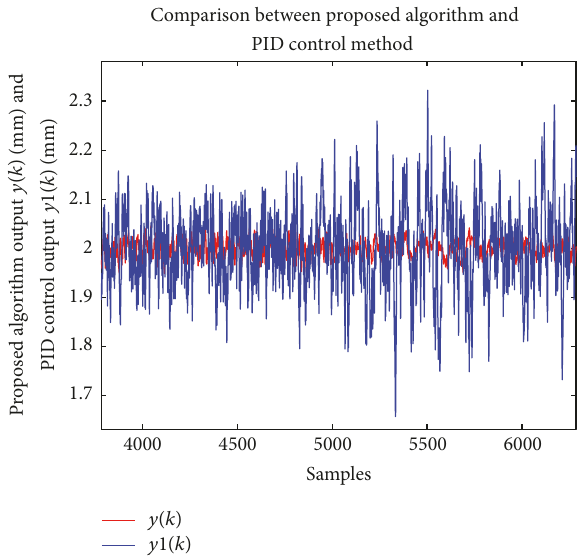
Figure 13: Detailed comparison between proposed algorithm (red) and PID control